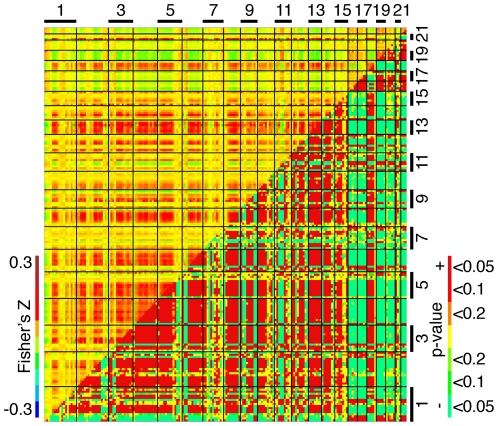
Genome-wide correlations between coexpression domains.Correlations between 30 Mb coexpression domains (15 Mb overlapping) on a genome-wide scale. The upper triangle represent mean z-transformed correlation coefficients; the lower triangle statistical significance determined by permutation analysis (100 permutations), with the threshold indicated by the color scale on the right side legend.